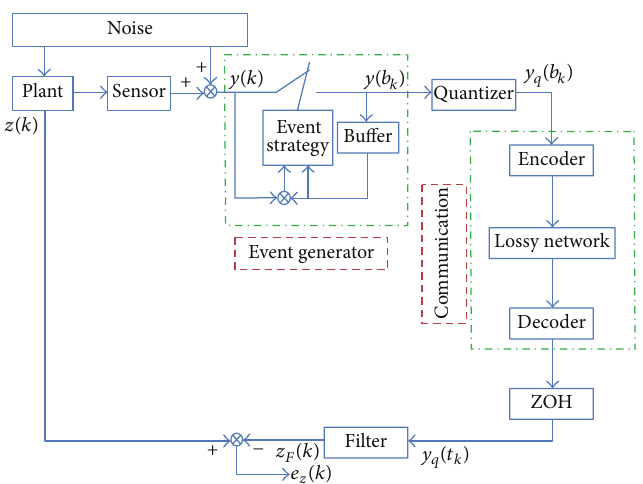
Figure 1: Scheme of event-triggered filtering with lossy network and